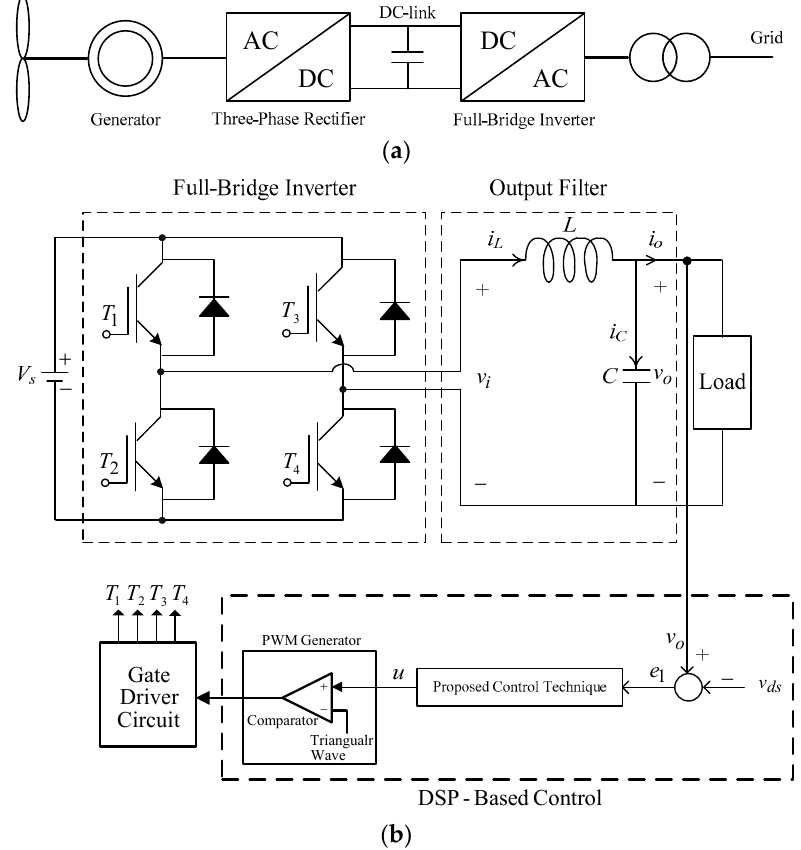
Figure 1. ( a ) Block diagram of a wind energy conversion system; ( b ) Full-bridge inverter and its